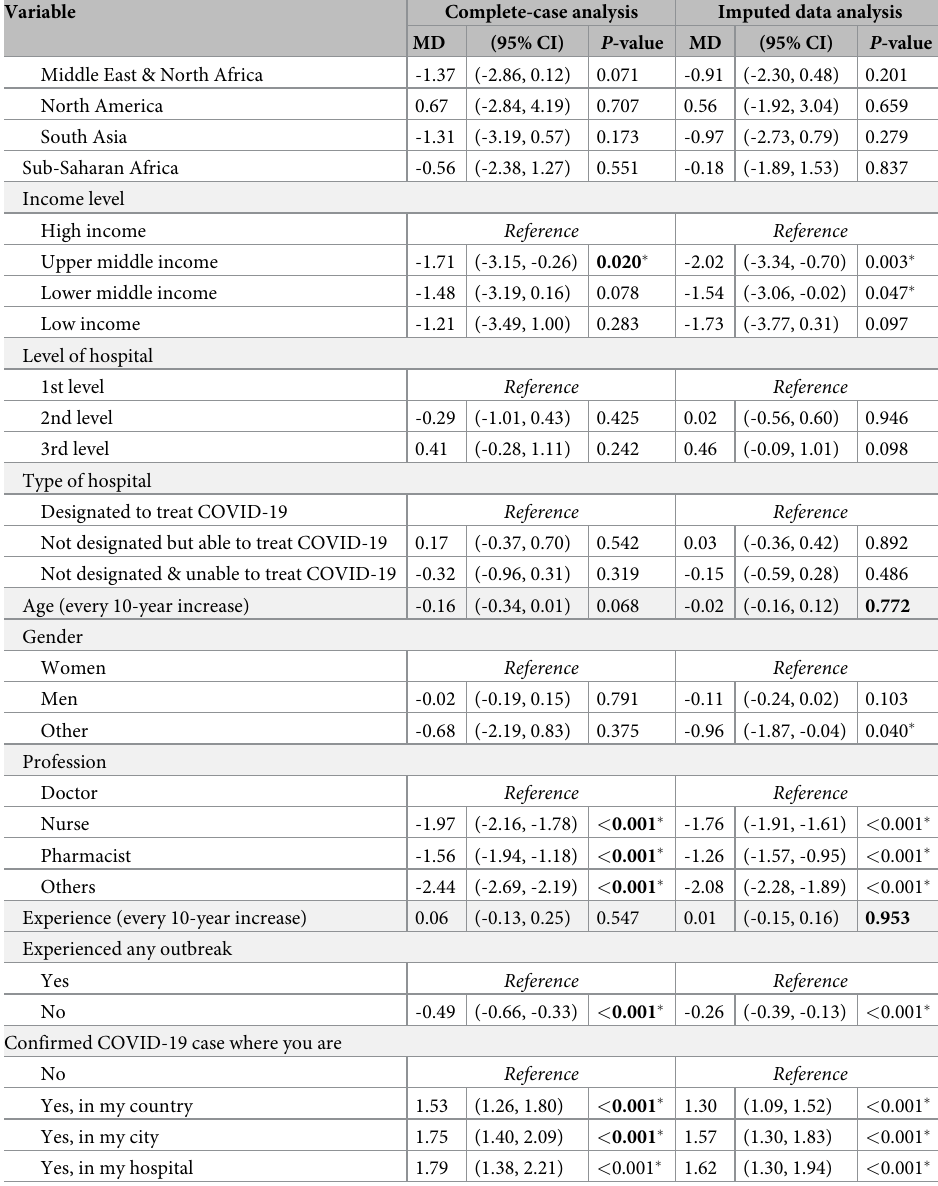
awareness scores. Participants from upper-middle income countries (MD -1.71; CI -3.15 to -0.26; P = 0.020) had significantly lower awareness scores compared to those from high income countries by complete-case analysis, a finding consistent with imputed data. Doctors served as the reference group, having the highest awareness scores, followed by pharmacists (MD -1.56; CI -1.94 to -1.18; P < 0.001), nurses (MD -1.97; CI -2.16 to -1.78; P < 0.001), and other profes- sions (MD -2.44; CI -2.69 to -2.19; P < 0.001); results were also significant in the